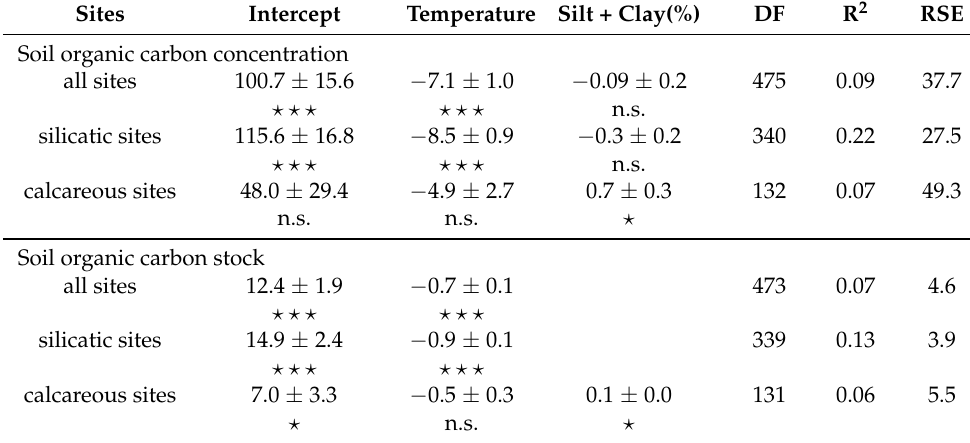
Table 4. Equations for estimating the soil organic carbon concentration (mgC/g) and the soil organic carbon stock (kgC/m 2 ), respectively, from mean annual temperature (°C) and the sum of silt and clay (%). The coefficients have been derived from a multiple stepwise regression. ‘DF’ ...degrees of freedom, R 2 ...coefficient of determination, RSE ...relative standard error. The statistical significance of the intercepts and coefficients is given by (cid:63) (cid:63) (cid:63) ... p < 0.001, (cid:63) ... p < 0.05 and ‘n.s.’ ...‘not significant’. The analysis is based on data of the Austrian Forest Soil Survey of